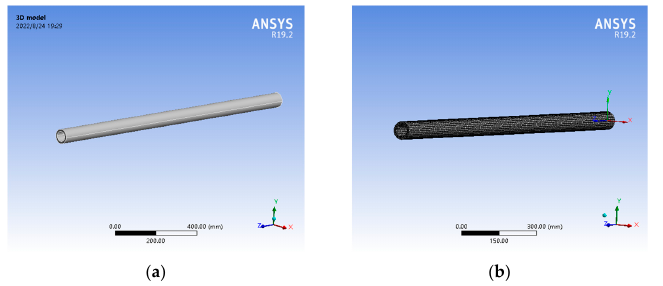
Figure 4. Three-dimensional solid model and finite element calculation model of FBG curvature sensor. ( a ) Three-dimensional solid model; ( b ) finite element calculation model. By imposing a fixed constraint on the negative end of the Z-axis of the sensor model and a negative bending moment around the X-axis on the positive end of the Z-axis, the bending of the sensor in the YOZ plane is simulated, and the bending curvature of the sensor can be obtained by deriving the node displacement of the sensor and fitting the curve. Therefore, the loading can be adjusted many times by dichotomy to control the radius of the curvature of this simulation to 15,000 mm, and then the orthogonal FBG strain data can be measured by inserting a path under different rotation error angles of the sensor model. When the FBG curvature sensor bends with a curvature radius of 15,000 mm, its equivalent strain and Z-direction elastic strain nephogram are as in Figure 5. It can be seen from Figure 5a that the FBG curvature sensor has negative bending along the Y-axis. After bending, the equivalent strain on the surface of the sensor macroscopically presents the characteristics of symmetrical distribution along the neutral surface. The surface strain of the neutral surface after bending is the smallest. With the transition to both sides of the neutral surface, the surface strain value gradually increases. In the plane where bending occurs, the innermost and outermost surface strains of the sensor are the largest. It can be seen from Figure 5b that when the FBG curvature sensor bends as shown in the figure, the strain on the neutral surface of the sensor is almost zero. On the positive side of the neutral surface along the Y-axis, the Z-direction elastic strain of the sensor is positive, that is, ten- sile strain. On the negative side of the neutral surface along the Y-axis, the Z-direction elastic strain of the sensor is negative, that is, the compressive strain.